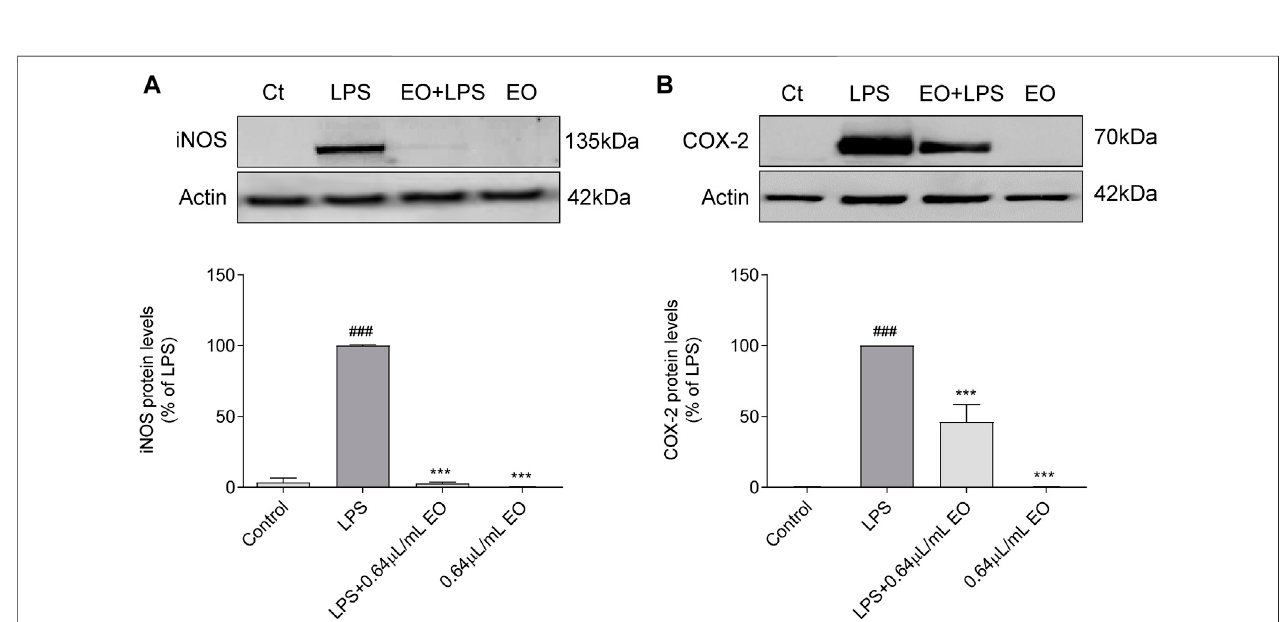
FIGURE 6 | Inhibitory effect of L. viridis L´Hér. essential oil (EO) on LPS-induced: (A) iNOS protein expression and (B) COX-2 protein expression in macrophages. Raw 264.7 cells were maintained in culture medium (control), or incubated with LPS, or with the essential oil (0.64 μ L/mL) alone or simultaneously with LPS for 24 h. ResultsareexpressedaspercentageofiNOSorCOX-2proteinlevelsrelativelytoLPS.Eachvaluerepresentsthemean ± SEMfromatleastthreeexperiments.Statistical differences between control and LPS groups were calculated using two-sided unpaired t -test and differences between a treatment condition and LPS alone was performed using one-way ANOVA followed by Dunnet ’ s post hoc test (### p < 0.001, compared to control; *** p < 0.001, compared to LPS).